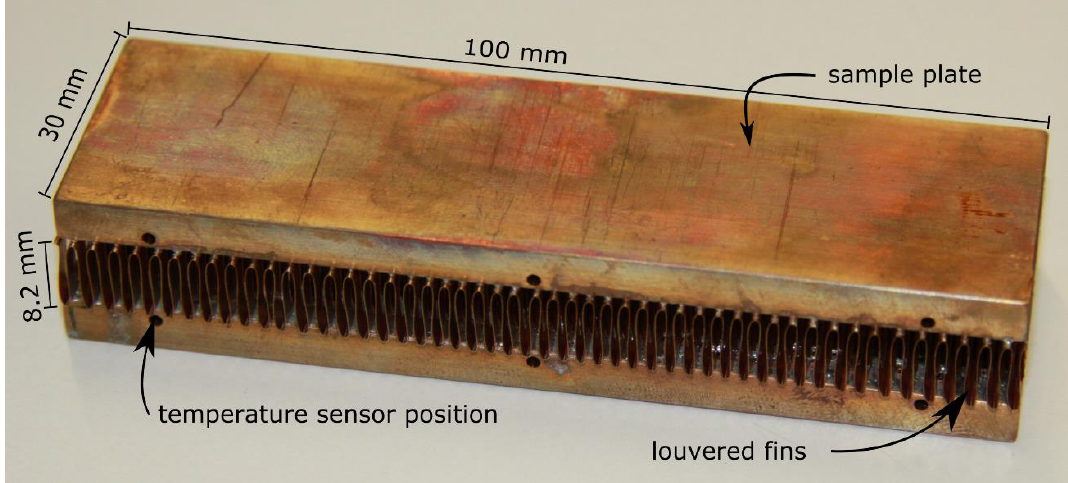
Figure 2. Louvered fin test core with top and bottom sample plate for experimental performance analysis.